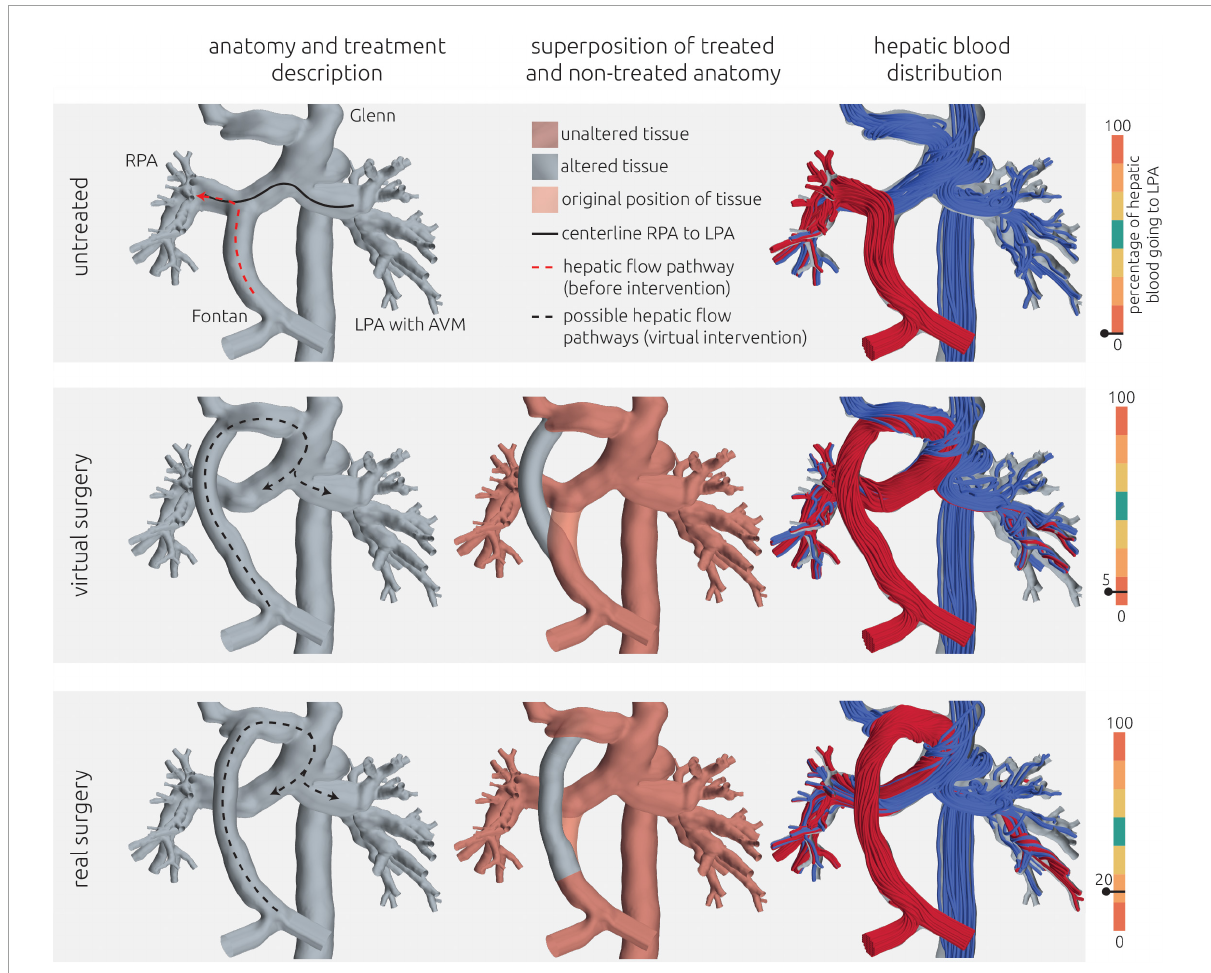
FIGURE9 Visualization of the estimated distribution of hepatic venous blood flow to the pulmonary arteries for the untreated patient-specific anatomy (top row), a virtual surgical approach (middle row) as well as the real surgical result (bottom row) for patient 3. In the left column, the anatomy of the conduit is shown together with the centerline from LPA to RPA (constant line) and the possible flow pathways for hepatic blood (dashed lines). The original pathways are highlighted in red, whereas the altered pathways after treatments are shown in black. In the central row, the untreated anatomy is superimposed as transparent red surface over the virtually modified anatomy, highlighting all regions that were altered. The right column shows the calculated distribution of hepatic blood (red) into LPA and RPA, as well as the distribution of blood coming from all other veins (blue). Hepatic blood flow distribution is indicated by the gauge to the